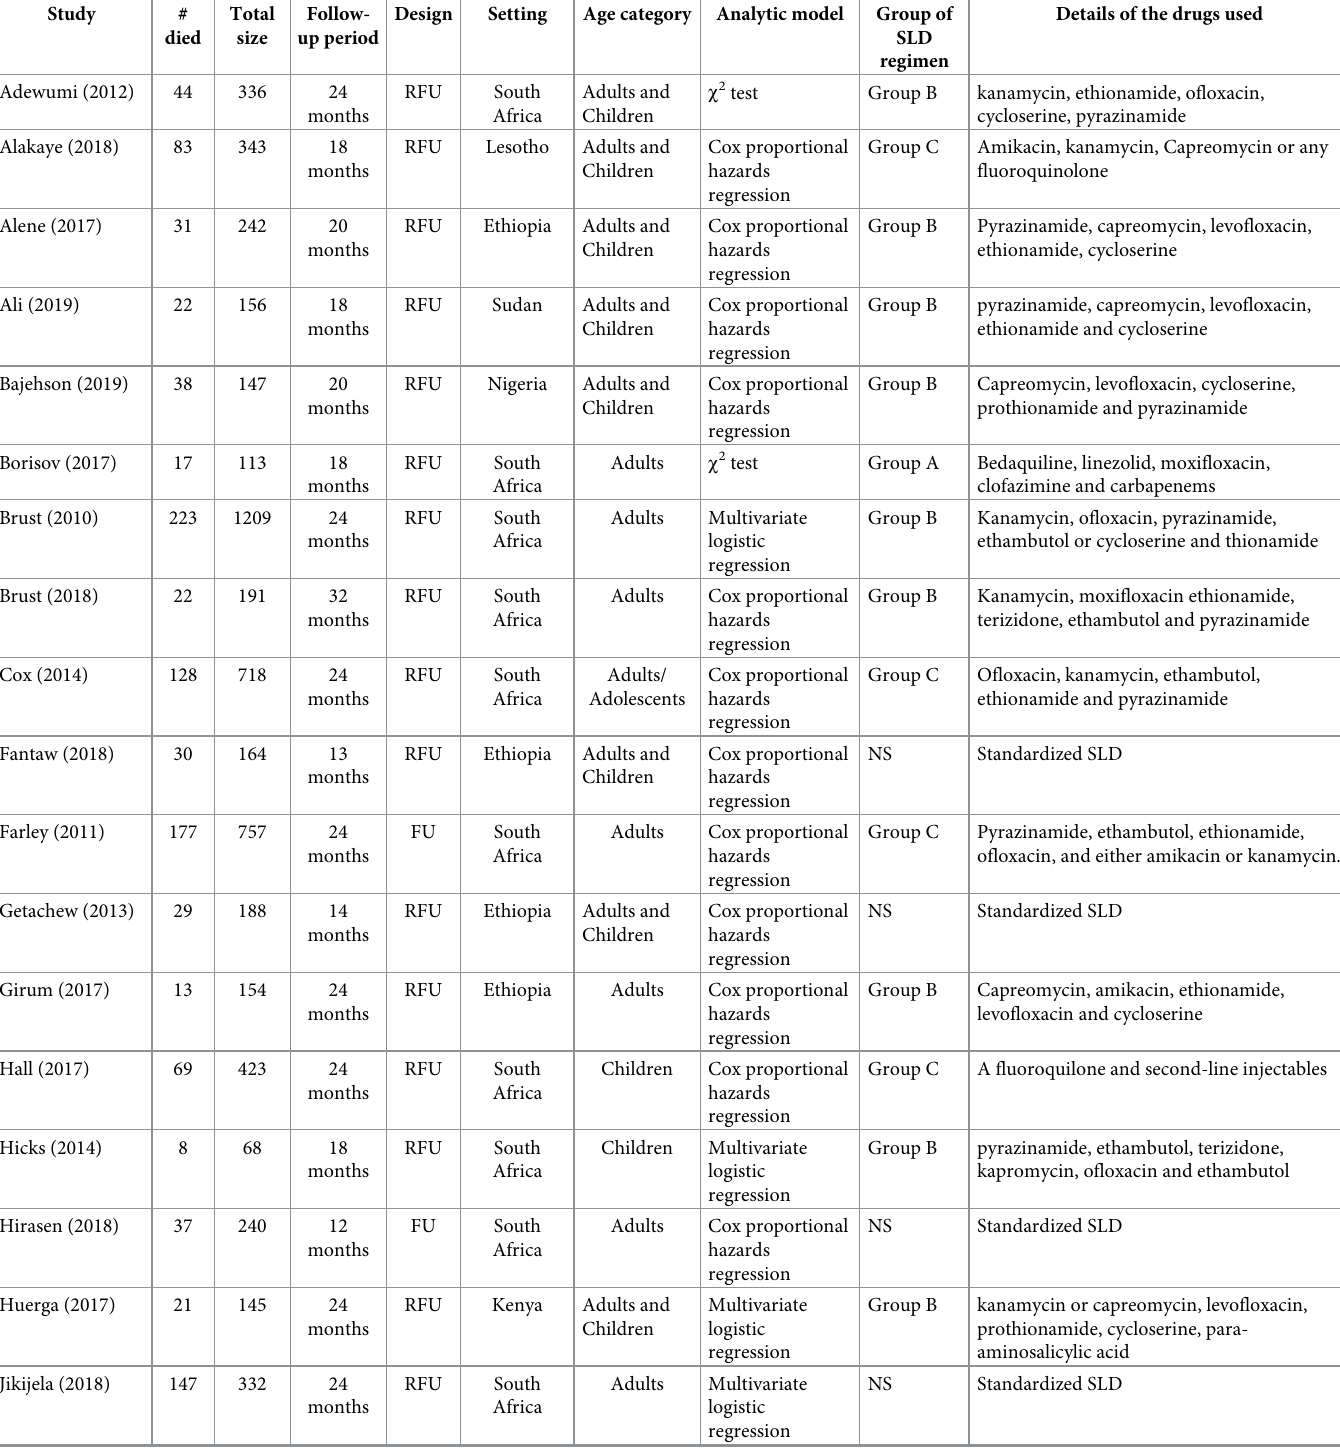
Table 1. Characteristics of identified publications and their analytic models of factor prediction for the SLD treatment